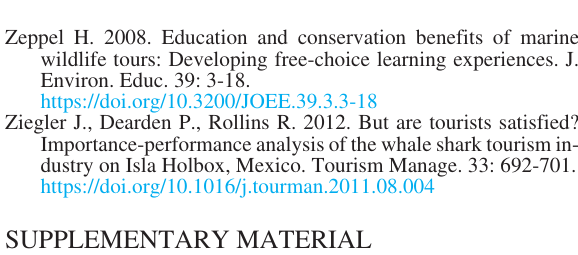
Table S1. – Search terms used to describe the published literature related to marine ecotourism in Baja California; x denotes use in the search. Table S2. – Table of the 47 publications identified and